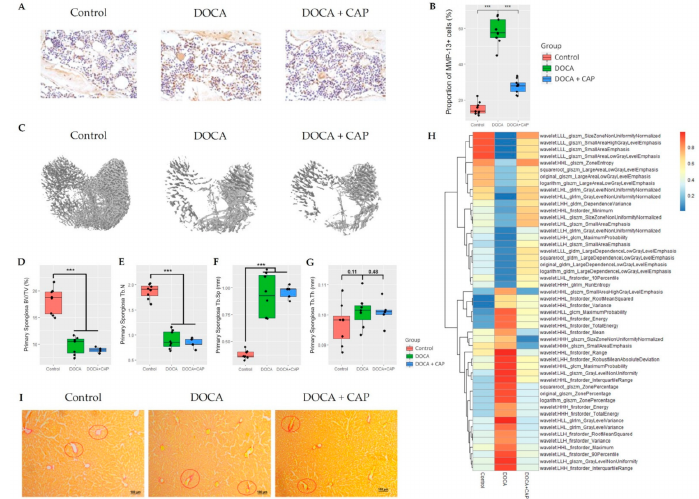
Figure A3. ( A ) The results of p16 staining in primary spongiosa of the control, DOCA, and DOCA + Captopril groups. ( B ) The bar chart shows the percentage of p16-positive cells in the samples (*** p < 0.001). ( C ) The 3D bone structure of primary spongiosa under micro-CT with the ( D ) bone volume ratio (BV/TV), ( E ) trabecular number (Tb.N), ( F ) trabecular separation (Tb.Sp), and ( G ) trabecular thickness (Tb.Th) calculated for the Control, DOCA, and DOCA + Captopril groups, respectively (*** p < 0.001). ( H ) The heatmap of the top 50 radiomic features quantifying the texture of primary spongiosa. ( I ) The Sirius red staining results of p16 staining in primary spongiosa of the Control, DOCA, and DOCA + Captopril groups. DOCA and DOCA + Captopril groups show more fibrosis than Control.